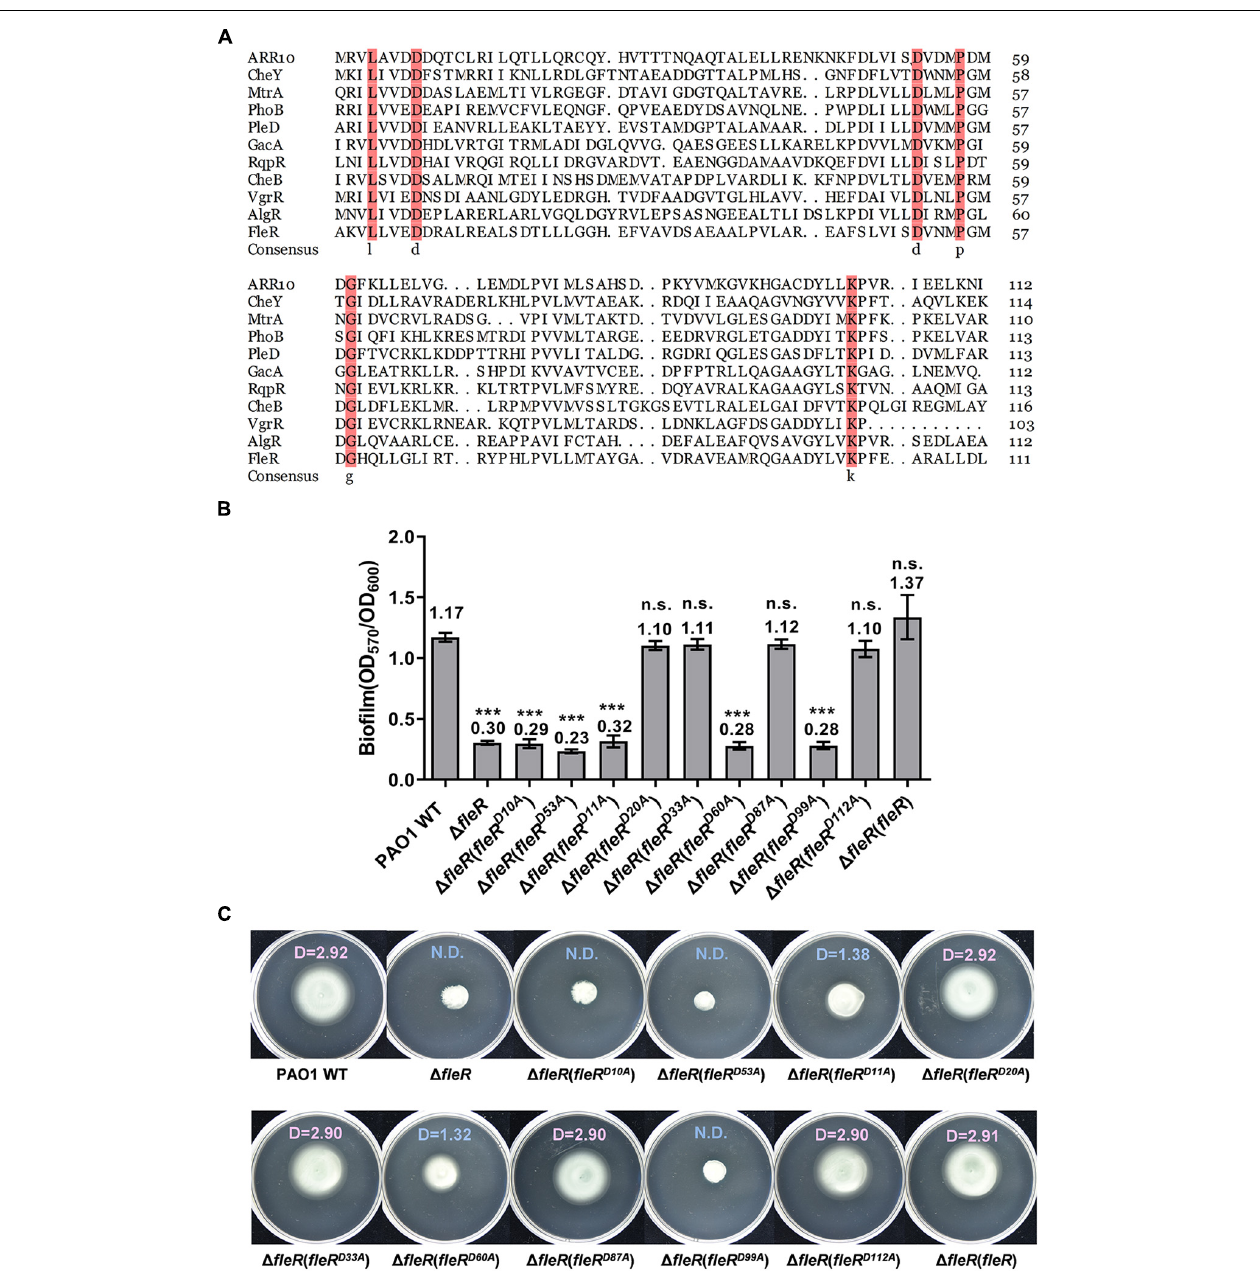
FIGURE 4 | Aspartate residues at positions of 10, 11, 53, 60, 99 in the REC domain of FleR are essential for the FleR activity. (A) Sequence alignment of the REC domain of FleR with 10 canonical REC domain sequences from ARR10 (NP_194920.1), CheB (WP_001350517.1), NreC (CPM47396.1), MtrA (AAB07804.1), PhoB (WP_000113933.1), PleD (WP_004620047.1), VgrR (WP_003490678.1), GacA (AAA68948.1), AlgR (AAA88427.1), and RqpR (CDN61654.1). The arrows indicated the potential aspartate residue to receive phosphoryl group. (B,C) The role of all the aspartate residues in FleR REC in controlling biofilm formation (B) and